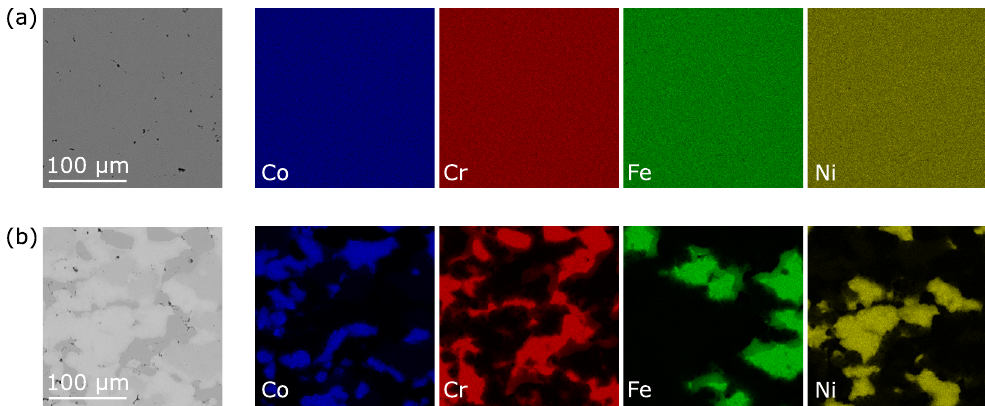
Figure 4. Backscatter electron images and energy-dispersive X-ray spectroscopy elemental maps of ( a ) the Alloytarget and ( b ) the